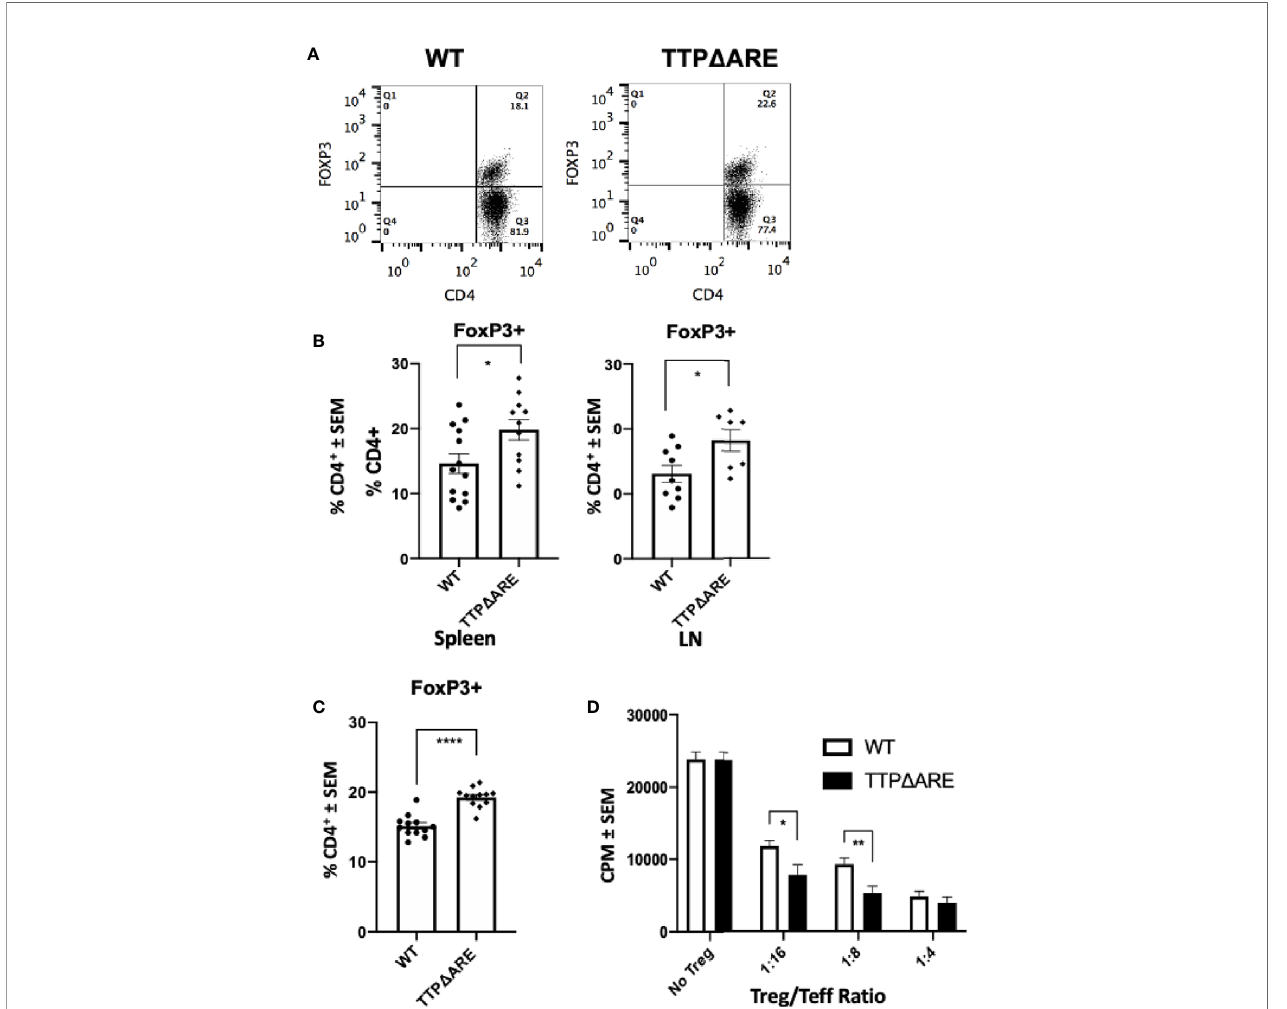
FIGURE 2 | The proportion of FoxP3+ regulatory cells and their inhibitory function are higher in TTP D ARE mice than in their WT controls. (A) Shows fl ow cytometric data from a typical experiment, demonstrating the higher proportion of FoxP3+ cells among spleen cells from the TTP D ARE mice than from the WT controls, gated on CD4 + population. (B) Summarizes three combined experiments with spleen and two experiments with LN cells. The spleen cells were collected from 13 WT and 11 TTP D ARE mice, whereas the LN cells were collected from nine and seven mice, respectively. Each dot represents data from an individual mouse. (C) Shows the relative proportions of FoxP3+ cells among peripheral blood cells from TTP D ARE mice and their WT controls. The data are values from 10 mice in each group. (D) The regulatory function of Treg cells from the two mouse genotypes was determined by the level of their suppression of the proliferative response of naïve T-cells stimulated by anti-CD3 antibody (see Materials and Methods for details). The fi gure combines data from two experiments. t-test was used for statistical comparisons, *p < 0.05, **p < 0.01 and ****p <